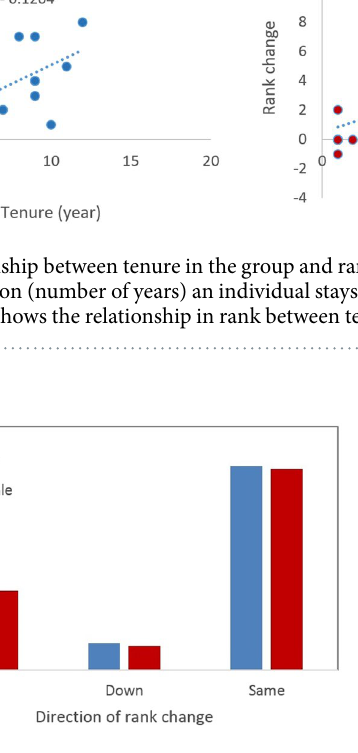
Figure 3. Percentage (%) of rank changes between two consecutive years (‘Up’ = upward change; ‘Down’ = downward change; ‘Same’ = no